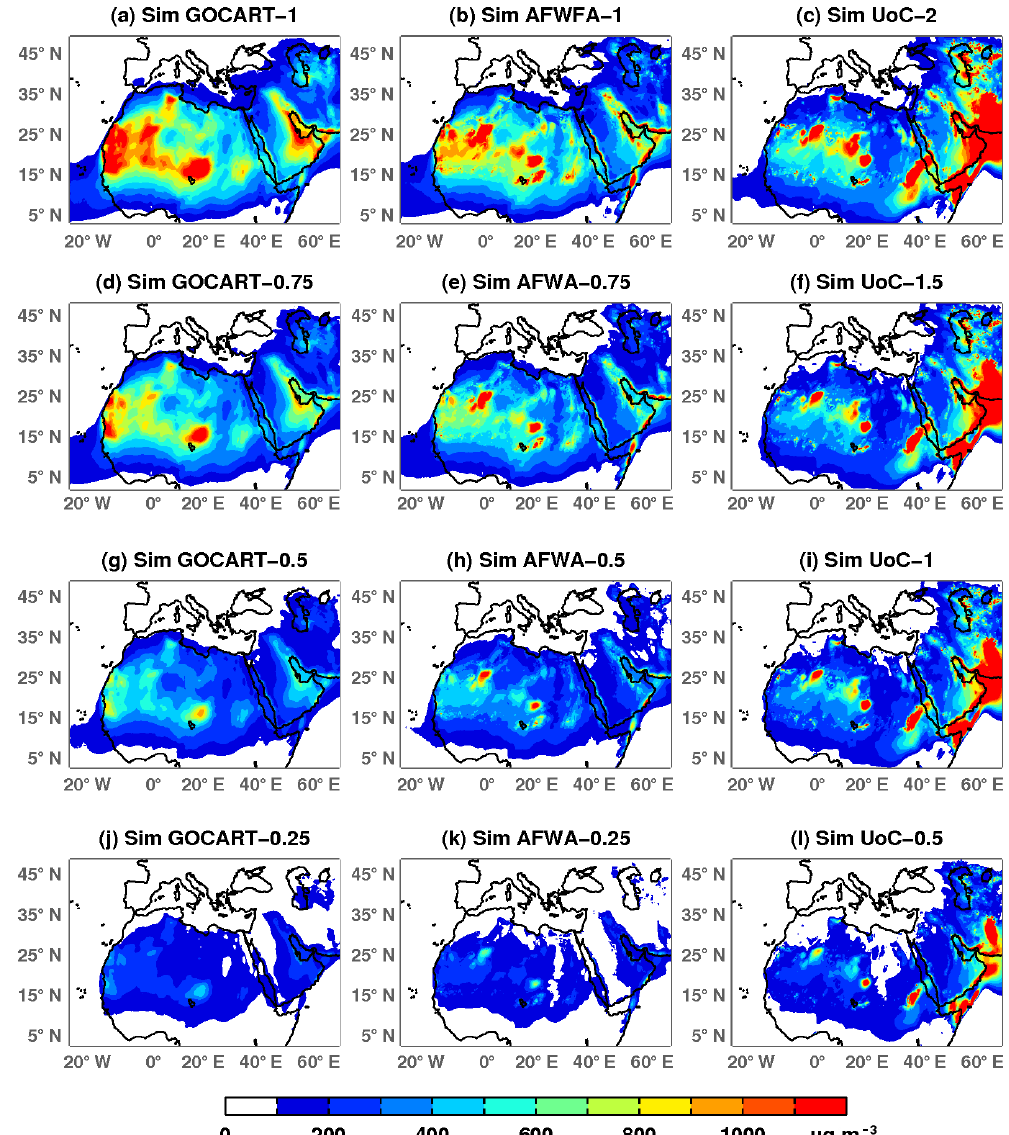
Figure 12. Near ground dust concentrations for all simulations, averaged over the 6-month